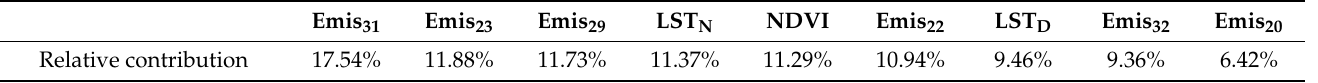
Table 4. Relative contributions ( RC ) of nine inputs to dew